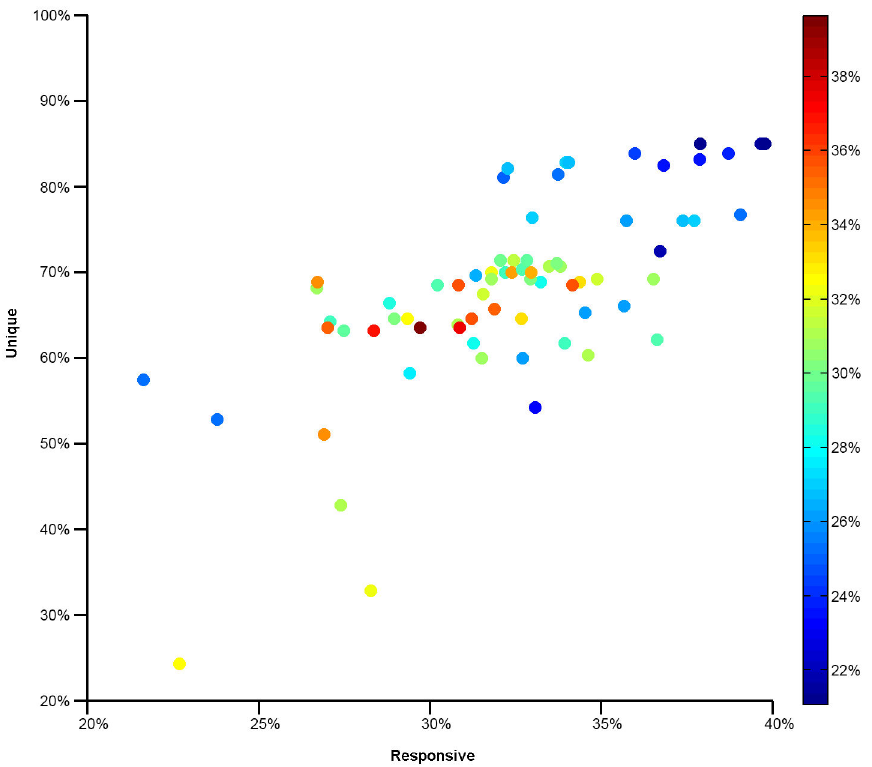
Figure 6. Learning the effects of drugs on gene expression levels across cell lines. Gene expression levels of the genes that varied most across drug treatments were used to form experimental observations across 48 cell lines. Each point represents a different number of phenotypes, varying from two (bottom left hand point) to 73 (upper right hand point). Warmer colors indicate greater experiment savings with an active